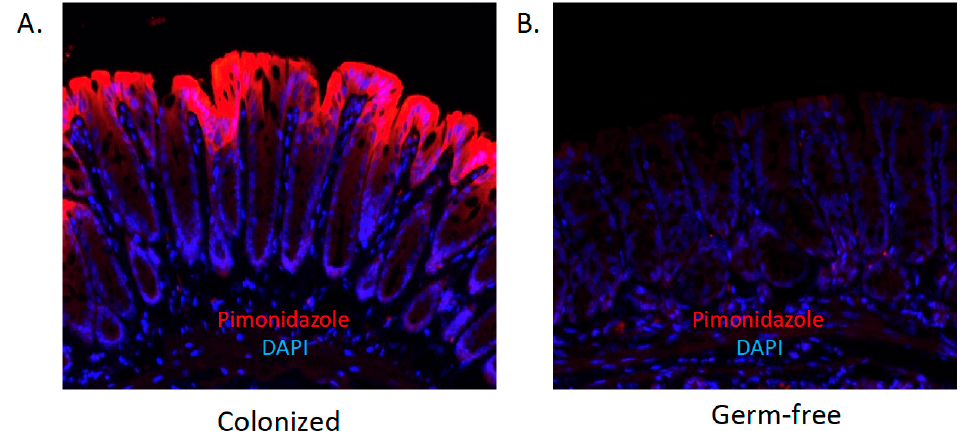
Figure 1. The contribution of the microbiota to “physiologic hypoxia”. Shown here are histologic sections of healthy colon derived from colonized ( A ) or germ-free ( B ) mice documenting low-oxygen regions (red) visualized by staining with pimonidazole, a dye that stains only in low-oxygen tensions. Nuclear counter-stain with DAPI is shown in blue. Note the near total lack of pimonidazole localization in the absence of microbial colonization.